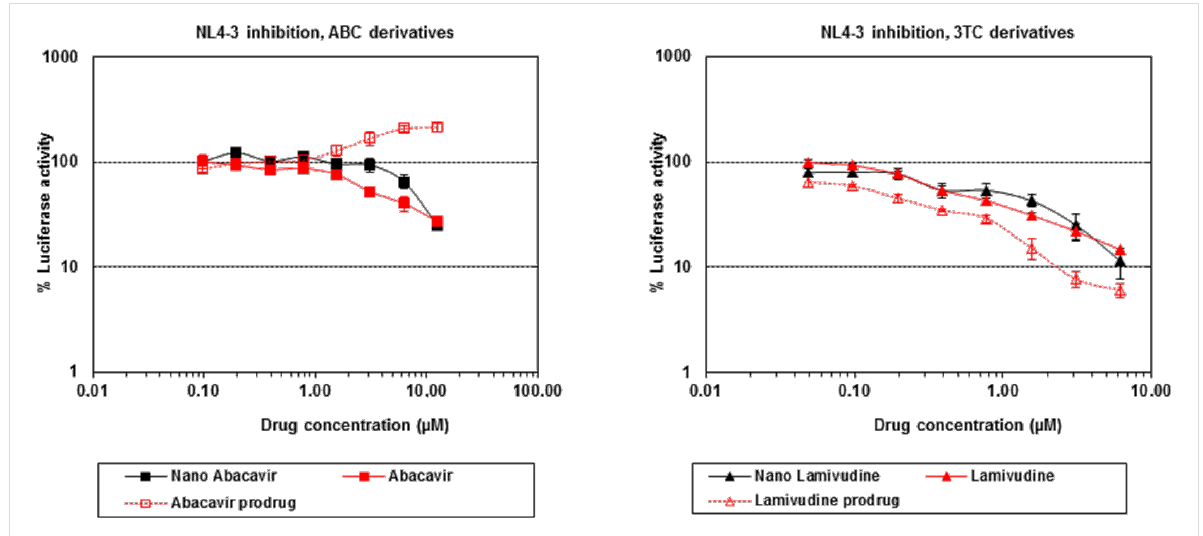
Figure 3: Cellular experiments: The two graphs show the percentage of luciferase activity decrease in the presence of increasing amounts of GNPs. ABC-GNPs (left) show an antiviral activity with an IC 50 of 8 µM. 3TC–GNPs (right) show an antiviral activity with an IC 50 of 1 µM.